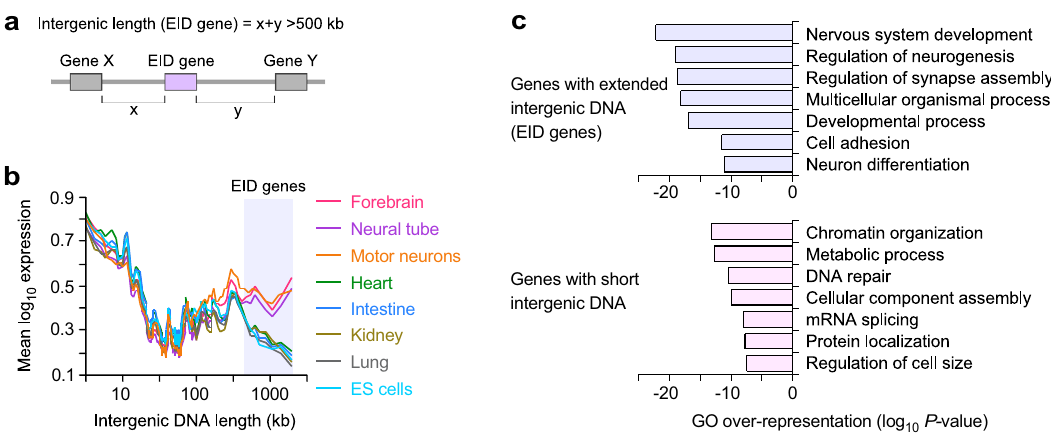
Fig. 3 Genes with long intergenic DNA are not highly expressed in neural tissues but repressed in non-neural tissues. a Illustration of intergenic lengths for EID genes (genes with extremely long intergenic DNA). EID genes have longer than 500 kb of intergenic DNA lengths. “ x ” and “ y ” indicate the upstream and downstream DNA distances to the ends of the nearest neighboring genes, X and Y, from the ends of focal genes. b Absolute gene expression levels (log 10 FPKM) in tissues shown in Fig. 1a and mouse ES cells, depending on the intergenic DNA lengths. The lines indicate the mean gene expression level for genes, binned according to the intergenic DNA lengths for each tissue (200 genes per bin, 18,383 mRNA genes). EID genes (shaded) are repressed in non-neural tissues and ES cells. c Gene ontology (GO) analysis for EID genes (1525 genes), shown in the shaded area in ( b ), and genes having short intergenic DNA regions (1848 genes with <10 kb of intergenic DNA lengths). The most enriched seven non-redundant GO terms are shown (Supplementary Data 6, 7). A one-sided Fisher ’ s exact test was used to calculate P -values in gene set enrichment analysis. P -values were not adjusted for multiple